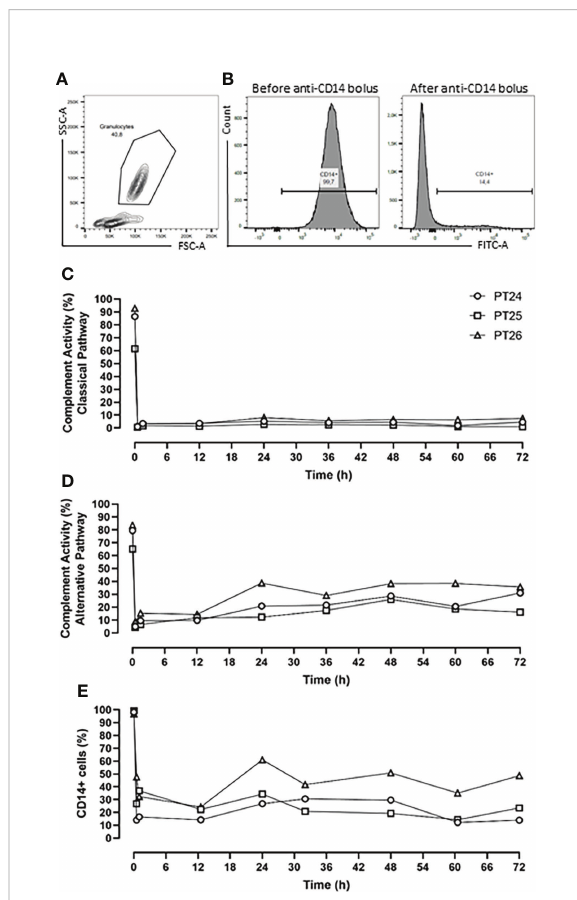
FIGURE 1 Pharmacodynamic analysis. (A) Flow Cytometry gating strategy of granulocyte. (B) Percentage of CD14+ cells before and after anti-CD14 (rMil2) application. (C) RA101295 (5mg/kg bolus, followed by 1.1mg/kg/h continuous infusion) blocked the classical pathway by 96%, and (D) the alternative pathway by 81%. (E) Simultaneous application of rMil2 (5mg/kg bolus at 30 min, 12-, 30-h, and 2.5mg/kg at 60-h) ensured CD14 antigen saturation of 75%. PT 24, PT25 and PT26 indicate experimental animal code in the treatment